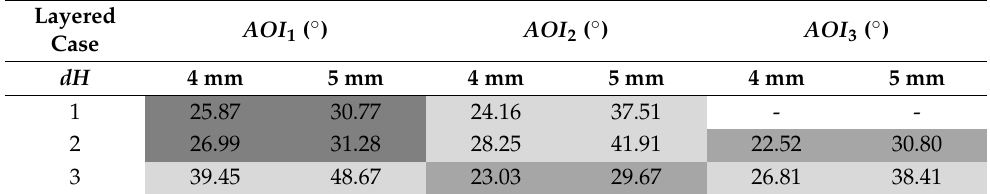
Table 2. Angle of intrusion for each Layered case at head differences dH = 4 and 5 mm. AOI 1 , AOI 2 and AOI 3 are the angles of intrusion in layers 1, 2, and 3, respectively. Cells are colour coded to match layer bead diameter, consistent with previous Figures 2–5, 10 and 11 (darkest = 1325 µ m, middle = 1090 µ m, lightest = 780 µ